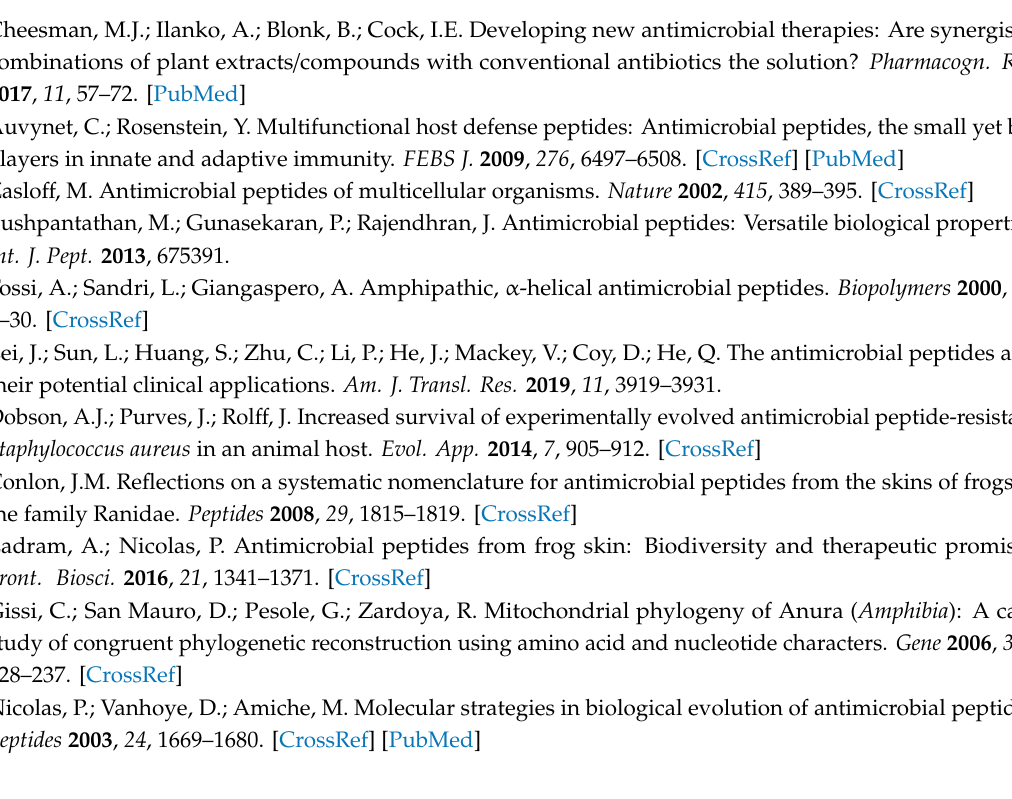
Figure S1: Deduced amino acid sequences of the mature G. susurra peptides, Figure S2: Predicted secondary structures of brevinin-2SSb, ranatuerin-2SSa, and granuliberin-SSa, Figure S3: A schematic diagram of